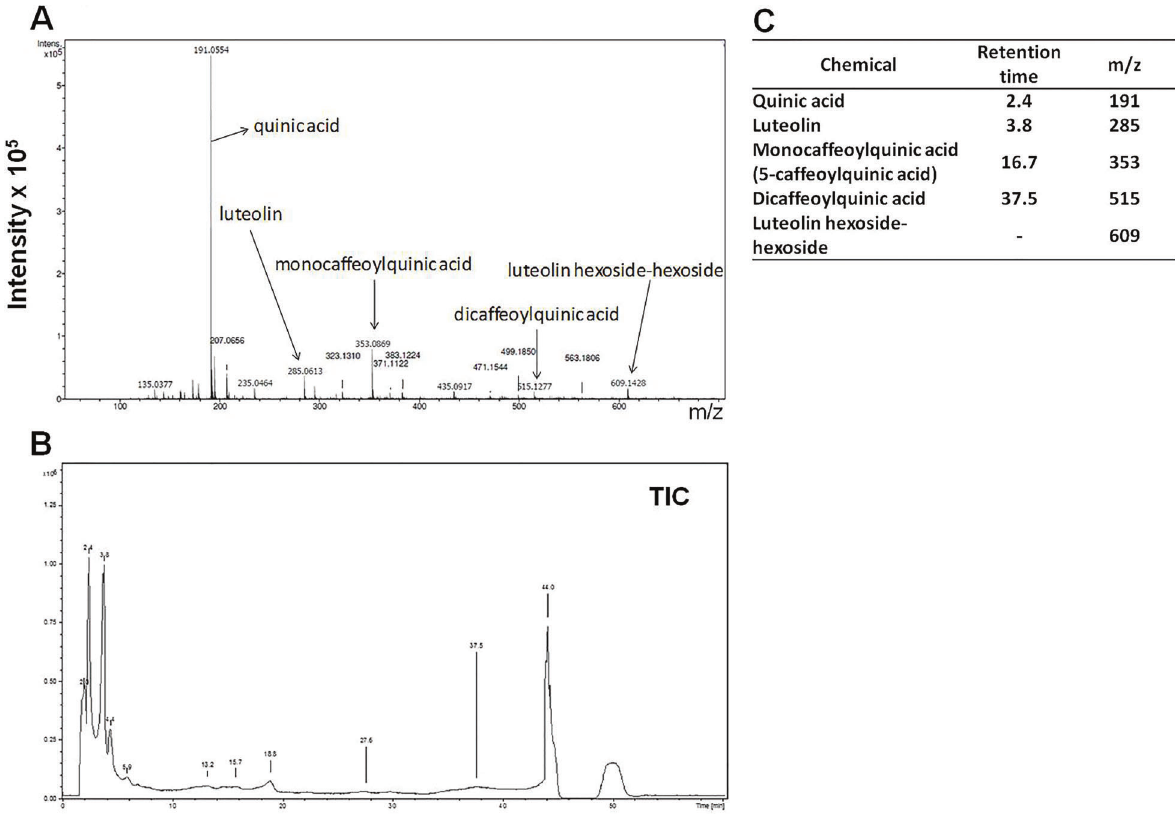
Figure 5. Representative ESI-MS and LC-PDA-MS analysis of the aqueous extract of Pseudobrickellia brasiliensis . A , ESI-MS full scan; B , total ion chromatogram (TIC), and C , chemical, retention time (in min), and